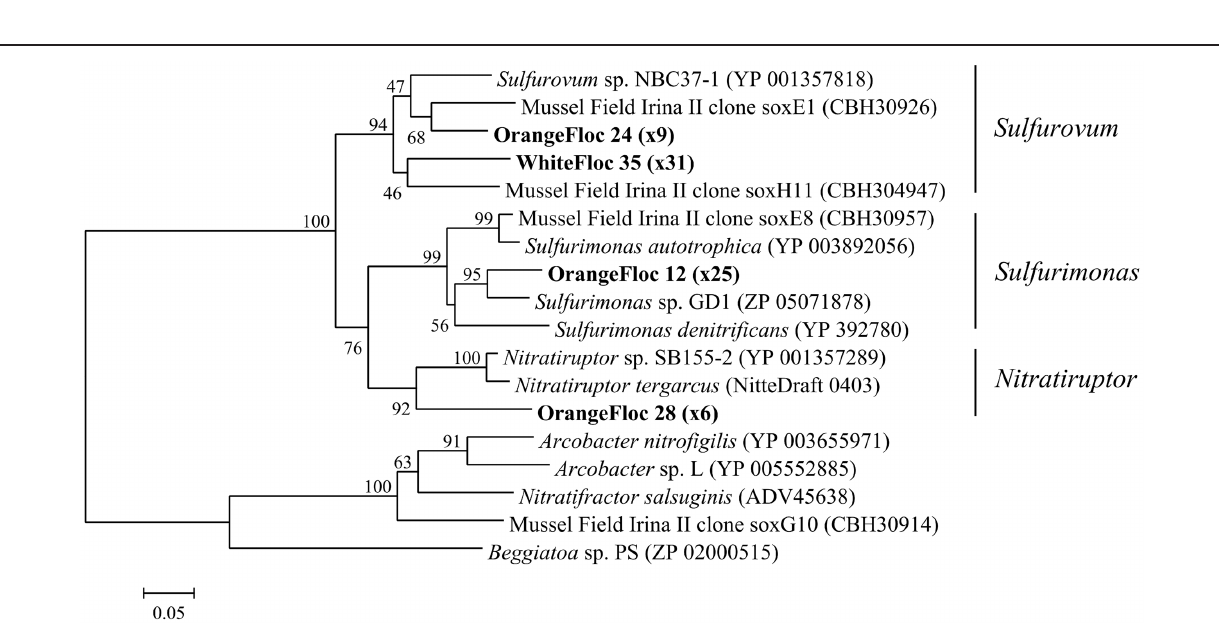
FIGURE 9 | Neighbor-joining tree of Epsilonproteobacterial soxB genes. The percentage of replicate trees in which the associated taxa clustered together in the bootstrap test of 1000 replicates is shown next to branches. Branch lengths are equal to the evolutionary distance